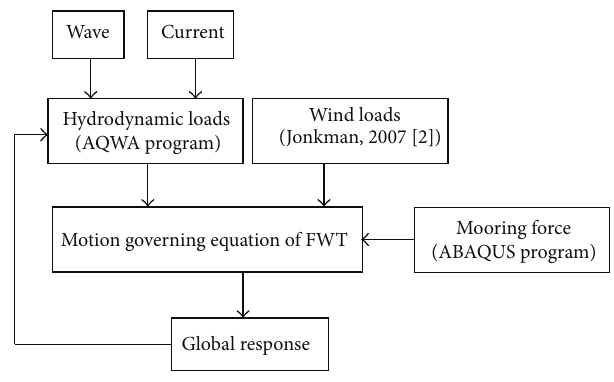
Figure 1: Computational